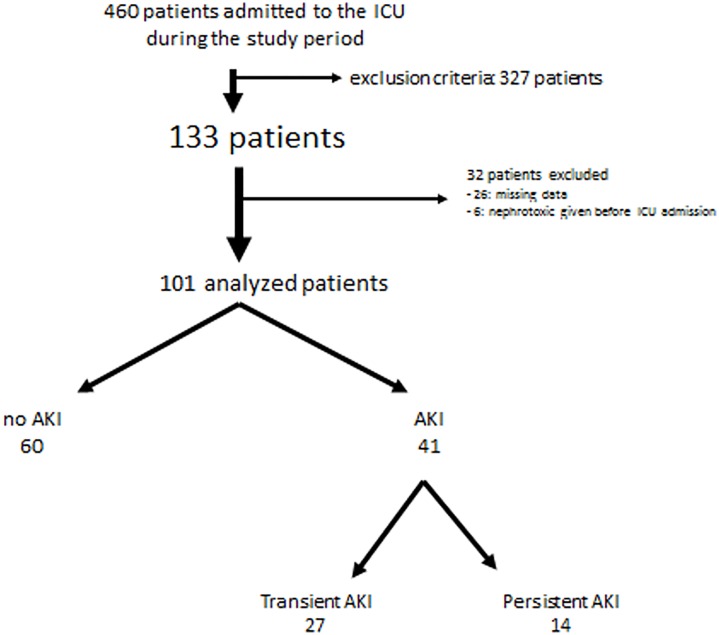
Flow chart of the study population.